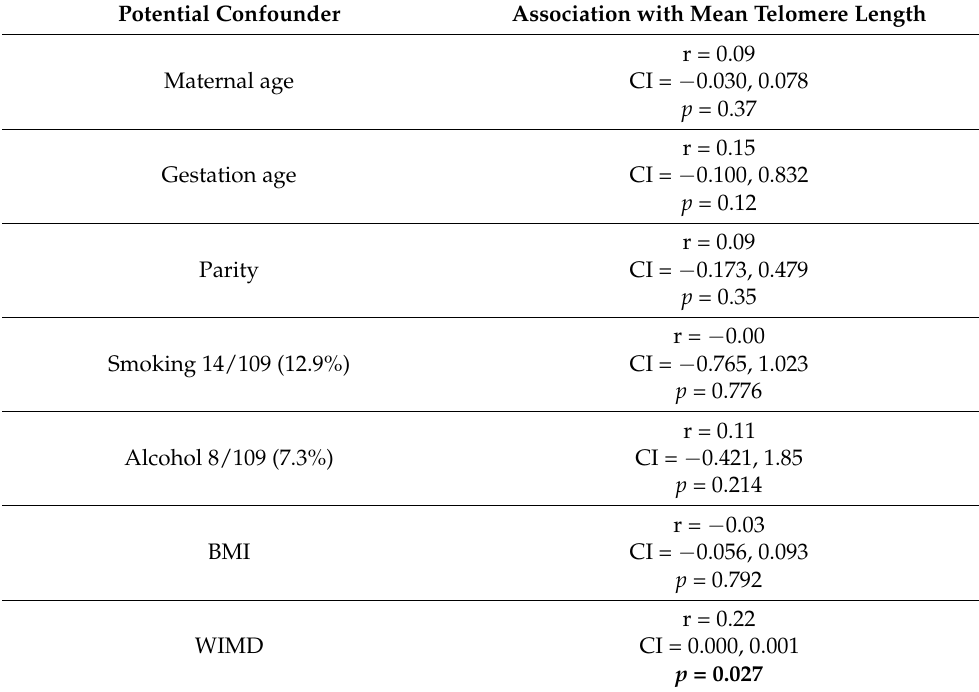
Table 1. Association between telomere characteristics and potential confounders. Number (%) is shown; p -values were assessed with Pearson or Spearman rho correlation; n = 109